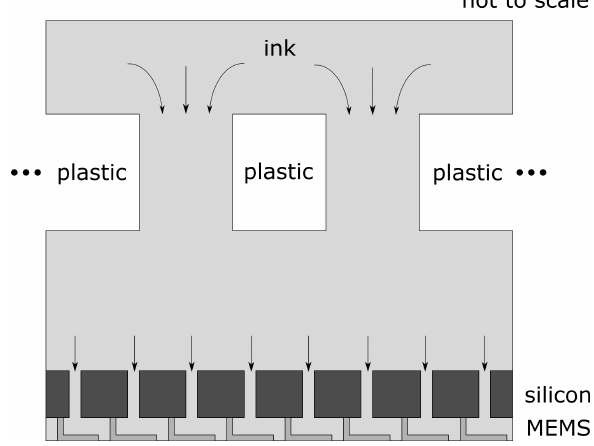
Figure 1. Flow in the printhead is driven by refill of the chambers in the MEMS layer. The nozzles at the bottom of the image experience a capillary suction pressure which is inversely proportional to the nozzle length scale. This capillary pressure draws ink from locations above the MEMS, via the feedhole in the plastic printhead layer.